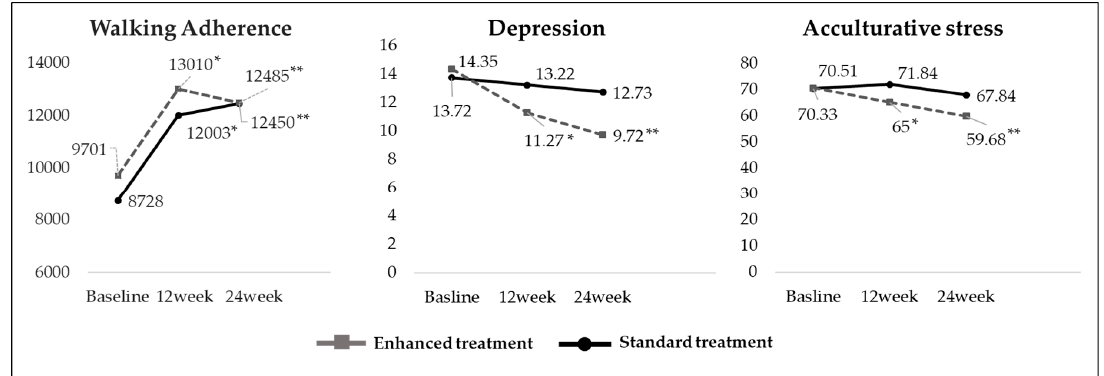
Figure 2. Comparison of walking adherence, depression, and acculturative stress levels between enhanced treatment (ET) and standard treatment (ST) groups over the 24-week study. * p < 0.05: difference between baseline and 12week, ** p < 0.05: difference between baseline and 24week.